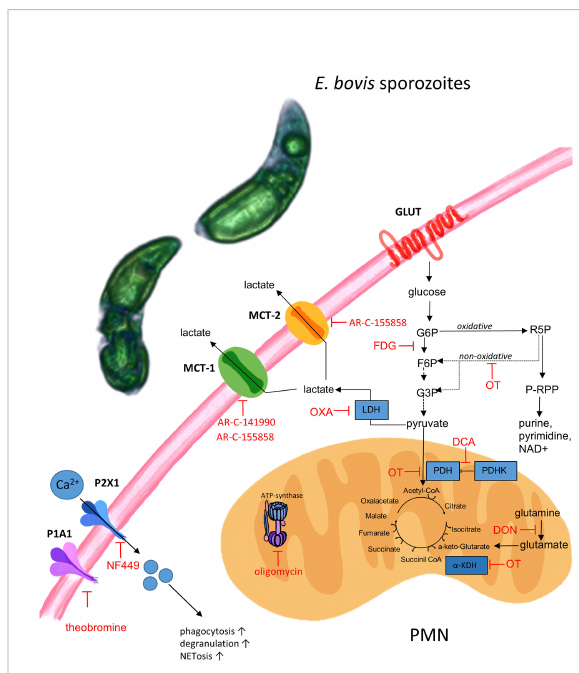
FIGURE 8 Schematic illustration of metabolic pathways and targets of inhibitors used in this study. FDG, fl uoro-2-deoxy-D glucose; DCA, dichloroacetate; OT, oxythiamine; OXA, oxamate; DON, 6- diazo-5-oxo-L-norleucine, oligomycin, NF449 (inhibitor of P2X1 receptor), theobromine (inhibitor of P1A1 receptor), AR-C141990 (MCT1 inhibitor), and AR-C155858 (inhibitor of MCT1 and MCT2). E. bovis sporozoites can activate bovine PMN due to a direct interaction to the cell or due to E. bovis -secreted soluble mediators. Activation of E. bovis confronted PMN triggers purinergic signaling (P2X, P1A receptors), monocarboxylate transporter function, and metabolic switches in order to sustain effector mechanisms as ROS production, phagocytosis, and NET formation. Pharmacological targeting of some of the actors demonstrate the fundamental role of energy-related molecules in E. bovis -induced PMN